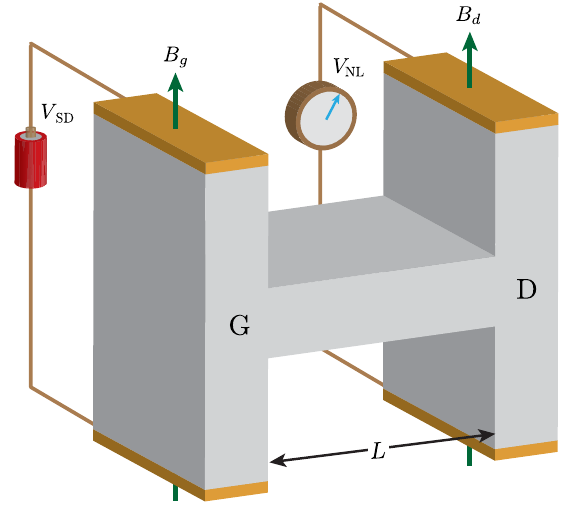
FIG. 5. H geometry. An alternative setup in which the generation and detection regions are massive, so that valley relaxation at the leads is diminished, making metallic contacts